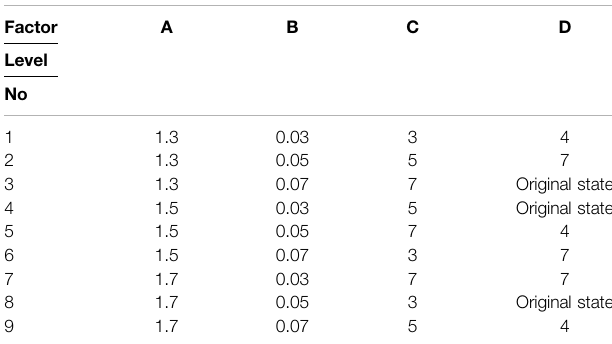
TABLE 3 | Test scheme